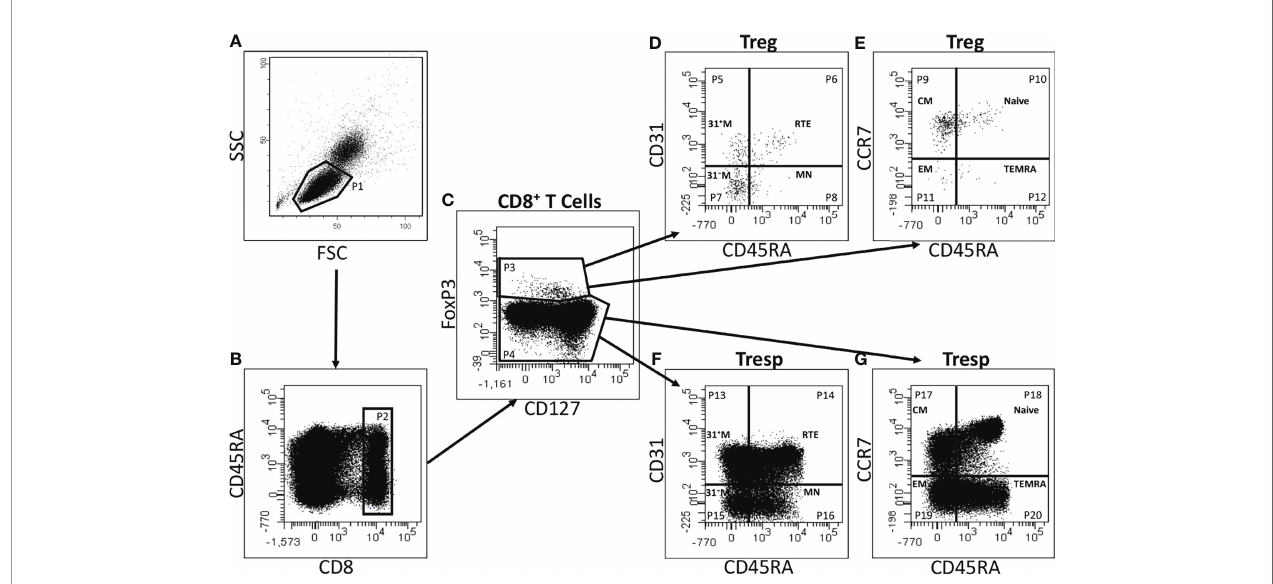
FIGURE 1 | Gating strategy for six-color- fl ow-cytometric detection of CD8 + CD127 low+/- FoxP3 + Tregs, CD8 + CD127 +/- FoxP3 - Tresps and their subsets. At fi rst, lymphocytes (P1) were identi fi ed by side scatter characteristics (SSC) versus forward scatter characteristics (FSC) (A) . The percentage of CD8 + T cells (P2) was estimated by analyzing the fl uorescence activity of CD8 versus CD45RA (B) . To separate Tregs (P3) from Tresps (P4), fl uorescence activity of FoxP3 versus CD127 was presented (C) . The percentages of RTE Tregs/Tresps (P6, P14), MN Tregs/Tresps (P8, P16), CD31 + memory Tregs/Tresps (P5, P13), and CD31 - memory Tregs/Tresps (P7, P15) were determined by analyzing the fl uorescence activity of CD31 versus CD45RA, respectively (D, F) . Naïve Tregs/Tresps (P10, P18), CM Tregs/Tresps (P9, P17), EM Tregs/Tresps (P11, P19), and TEMRA Tregs/Tresps (P12, P20) were identi fi ed by estimating the fl uorescence activity of CCR7 versus CD45RA (E, G)